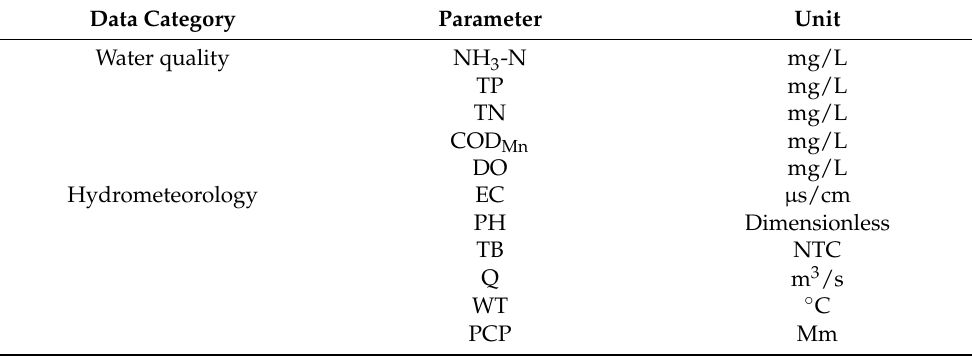
Table 3. Pollution and hydrometeorology data